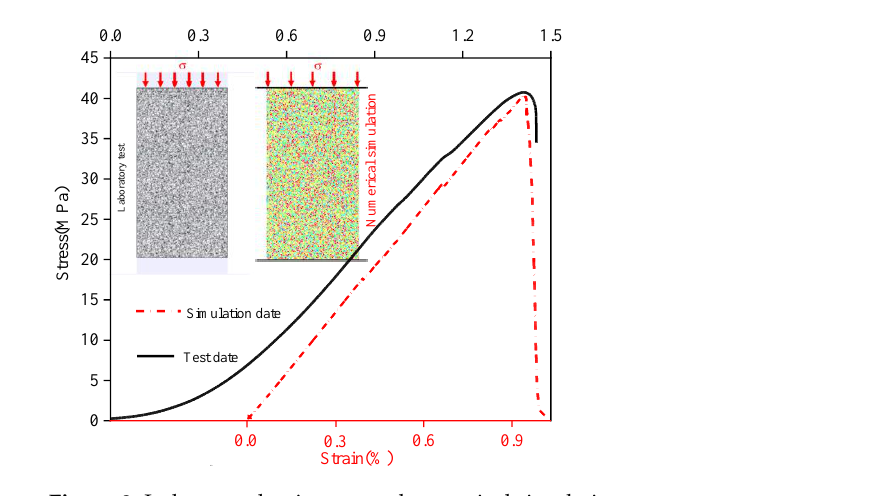
Figure 8. Indoor mechanics test and numerical simulation. Table 7. Indoor mechanics test results and numerical simulation results under different freeze-thaw